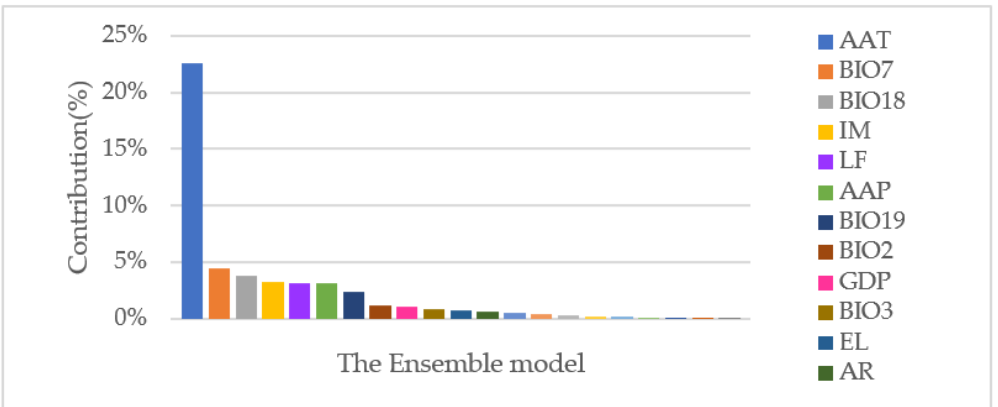
Figure 4. Environmental factors were dominant for risk prediction of the ensemble model.